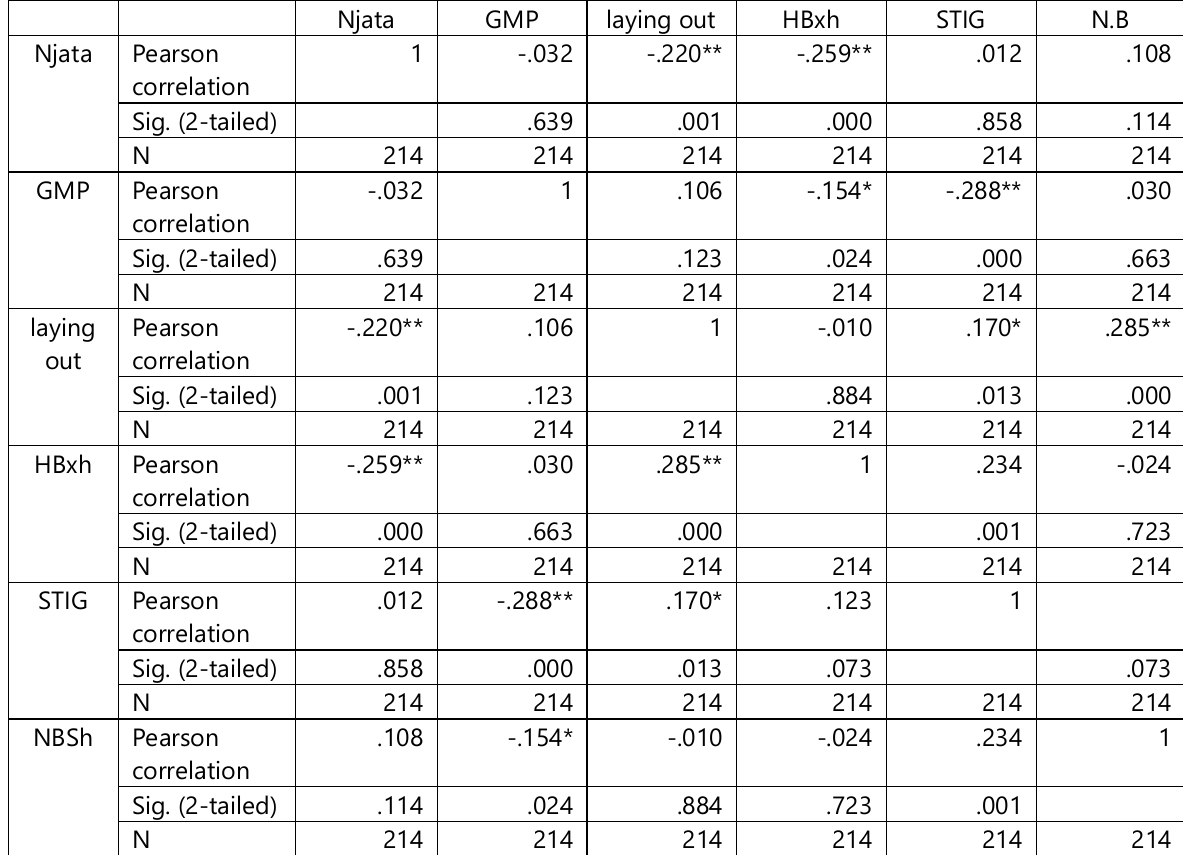
Table 9: Correlation Matrix Table (Source: Authors’ calculation) Njata GMP laying out HBxh STIG N.B Njata Pearson -.032 -.220** .108